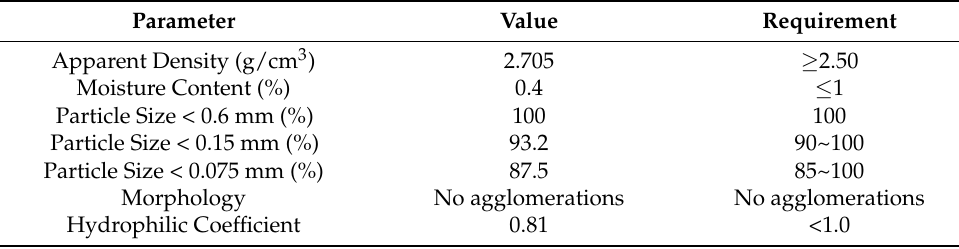
Table 3. Technical indicators of filler.